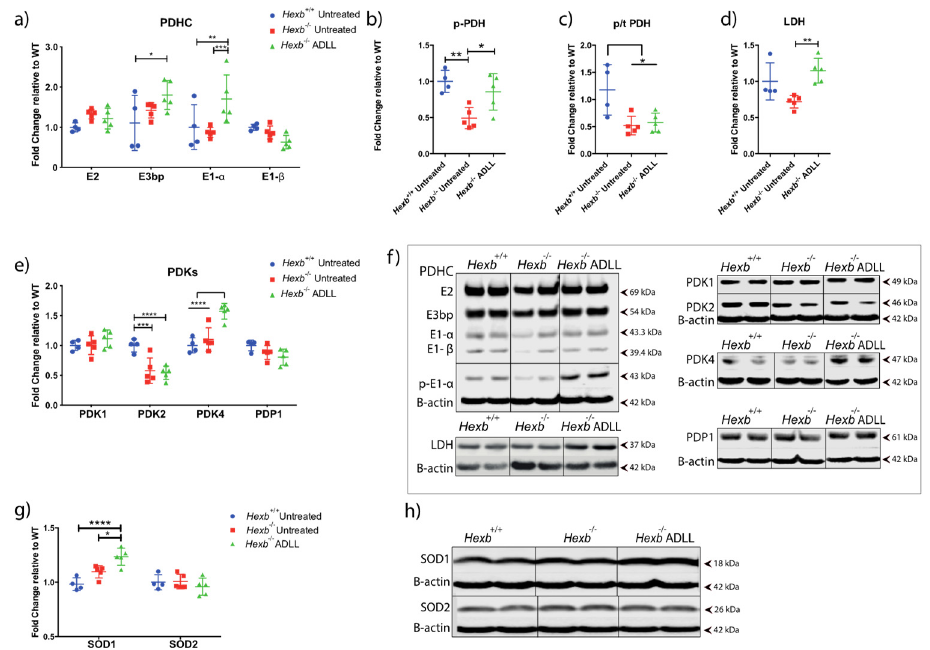
Figure 4. Effects of acetyl-DL-leucine on glucose and antioxidant metabolism in the cerebellum of 12-week-old Hexb - / - mice. ( a ) PDHC protein expression, mean ± SD, * p = 0.0105, ** p = 0.0097, *** p = 0.001 (two-way ANOVA). ( b ) p -PDH expression, mean ± SD, * p = 0.0310, ** p = 0.0062 (two-way ANOVA). ( c ) p-PDH / -tPDHE1 α ratios, mean ± SD, * p < 0.023 (two-way ANOVA). ( d ) LDH expression, mean ± SD, ** p = 0.0071 (one-way ANOVA). ( e ) PDK 1-2-4 and PDP1 expression, mean ± SD, *** p = 0.0002, **** p < 0.0001 (two-way ANOVA). ( f ) Western blot images of PDHC, p-PDH, LDH, PDKs and PDP1 along with their β -actin controls. ( g ) SOD1 and SOD2 expression, mean ± SD, * p = 0.0216, ** p = 0.0121, **** p < 0.0001 (two-way ANOVA). ( h ) Western blot images of SOD1 and SOD2 and their β -actin loading controls. Samples on the same blots were cut (inserted lines) for appropriate visual representation.